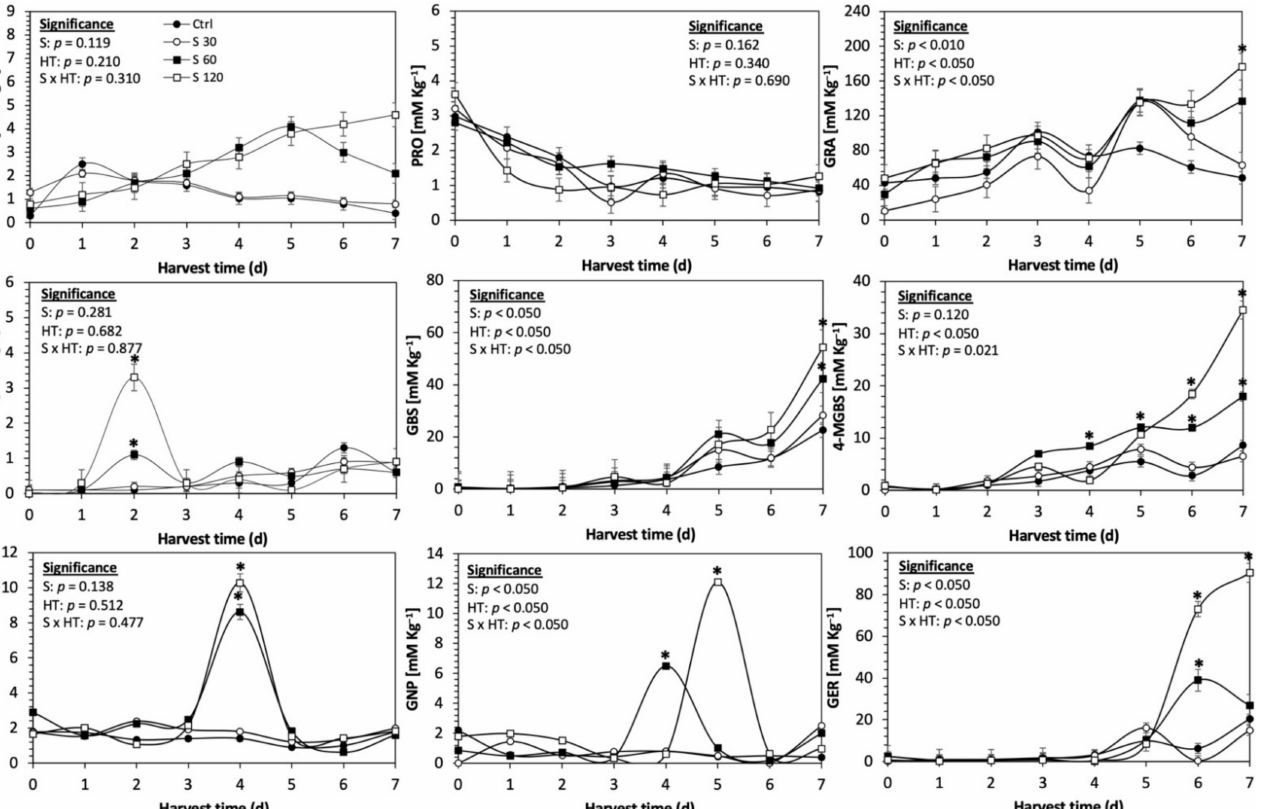
Figure 5. Concentration of individual glucosinolates in untreated Red Russian kale sprouts and treated with sulfur during the first 7 days of germination. Bars are means of 3 replicates ± standard error. Data points with an asterisk (*) indicate statistical difference determined by a t -test ( p < 0.050) be- tween the control and treated samples. Abbreviations: sulfur (S), harvest time (HT), glucoiberin (GIB), progoitrin (PRO), glucoraphanin (GRA), 4-hydroxy-glucobrassicin (4-HGB), glucobrassicin (GBS), 4-methoxy-glucobrassicin (4-MGBS), glucoeurocin (GER), gluconapin (GNP), and neoglucobrassicin (NGBS). Results are expressed as desulfogucoraphanin equivalents in dry weight